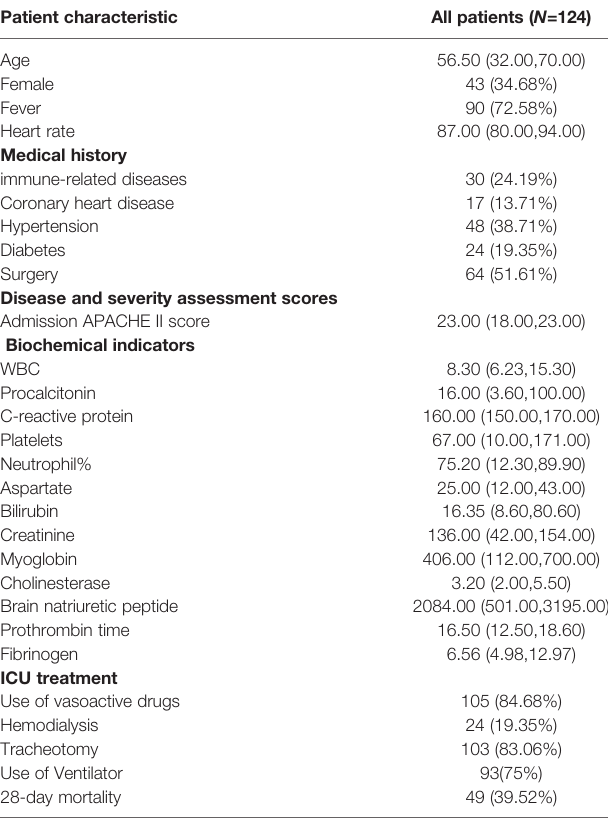
TABLE 1 | Biochemical indicators, clinical features, and past medical